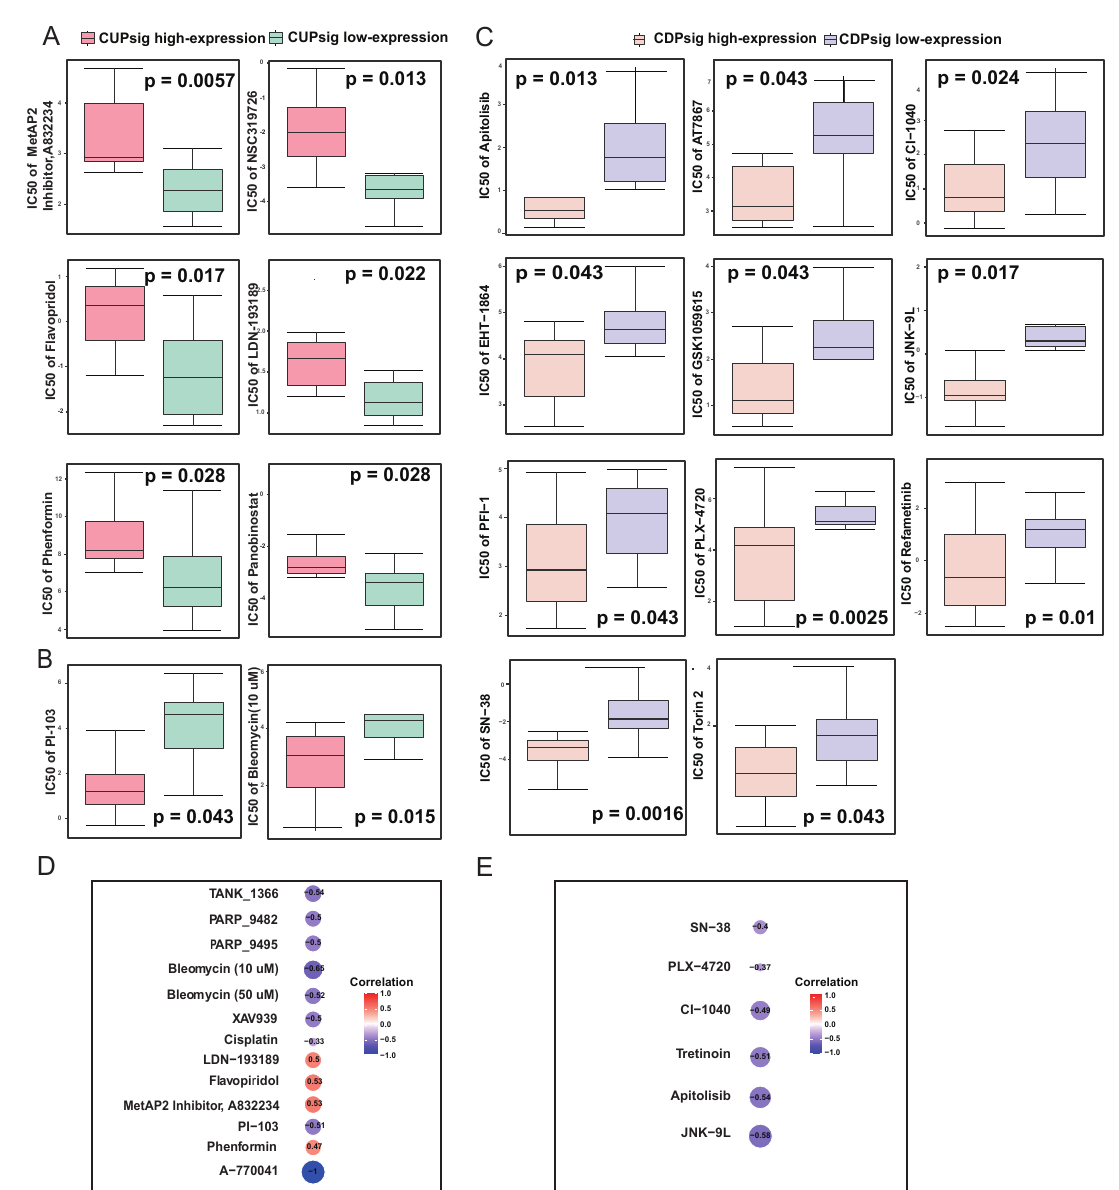
Figure 6. The relationships between CUPsig and CDPsig expressions and drug sensitivities: ( A , B ) Differences in IC50 values of CRC cell lines treated with eight drug components between CUPsig high- and low-expression groups; ( C ) differences in IC50 values of CRC cell lines treated with 11 drug components between CDPsig high- and low-expression groups; ( D , E ) correlations between CUPsig and CDPsig expression levels and drug sensitivity (IC50). A positive (or negative) correlation means that the CRC cell line with high expression of CUPsig and CDPsig was resistant (or sensitive) to the drug: ( D ) CUPsig, ( E )